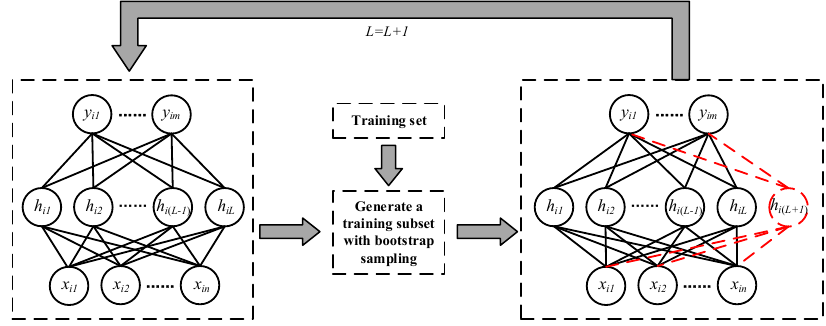
Figure 2. The flow of Bootstrap-SCN method.